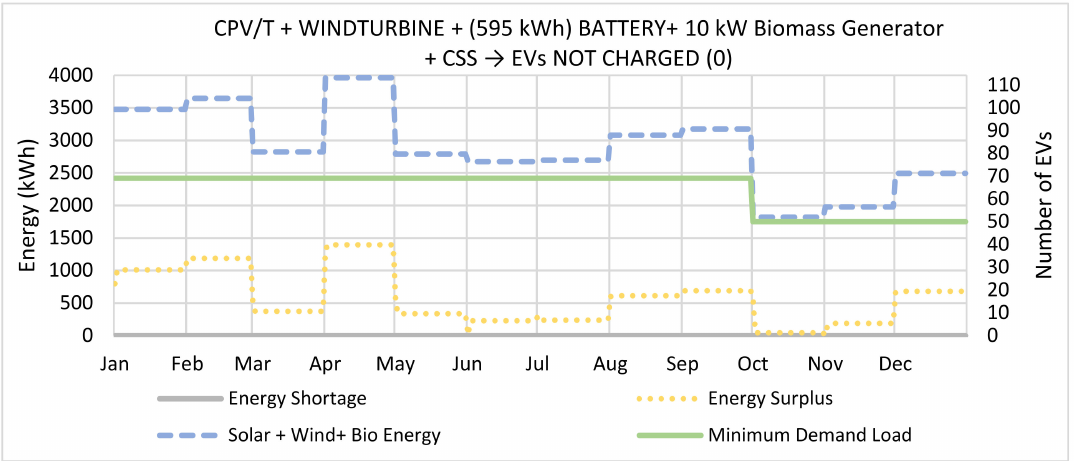
Figure 17. CPV / T, WT and bio-generator with BSS and CSS annual simulation results.